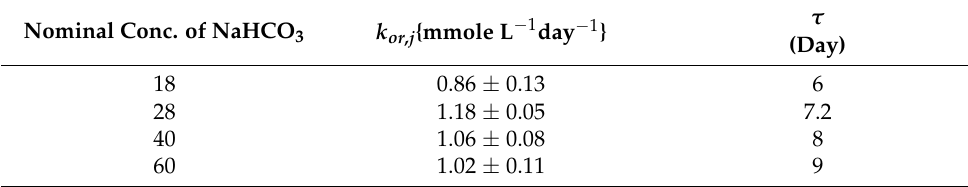
Table 3. Reaction rate constants for total organic carbon formation and growth phase time.